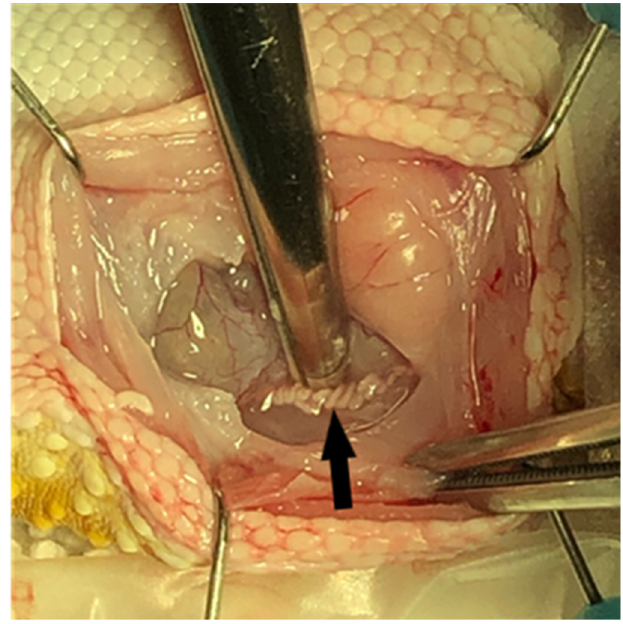
Figure 4. Visualization of right epididymis (arrow) in body cavity prior to